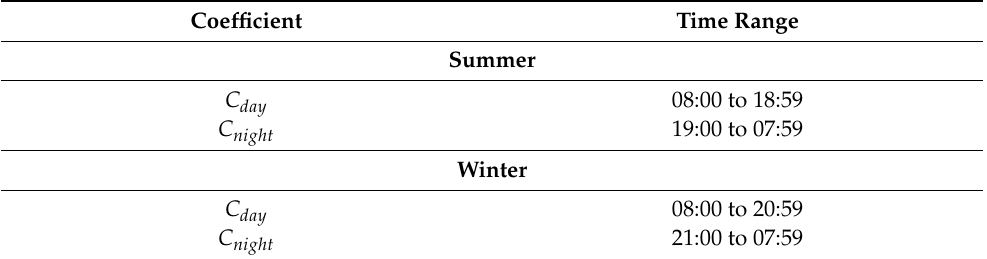
Table 1. Air-conditioning critical coefficients.